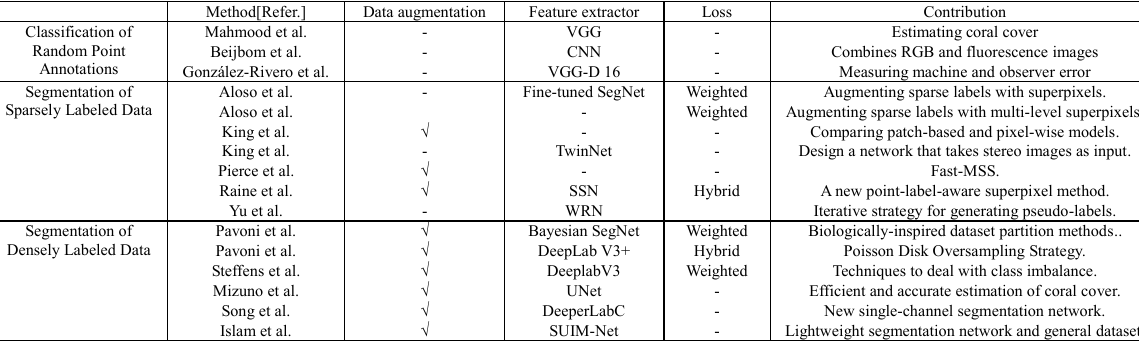
Table 1 . Summary of coal image segmentation